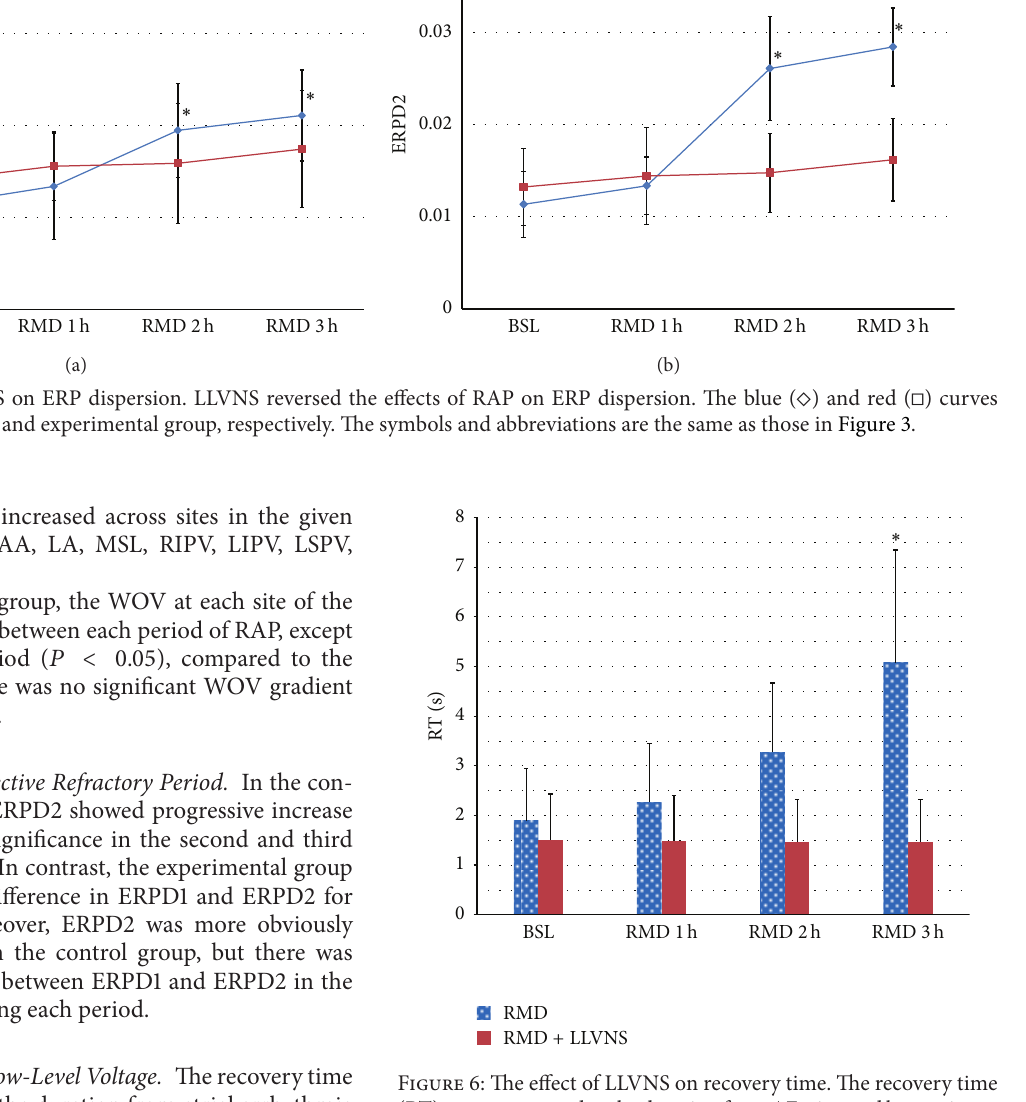
Figure 6: The effect of LLVNS on recovery time. The recovery time (RT)wasrepresentedasthedurationfromAFtriggeredbypersistent S 1 -S 1 stimulation to sinus rhythm. Abbreviations are the same as those in Figure